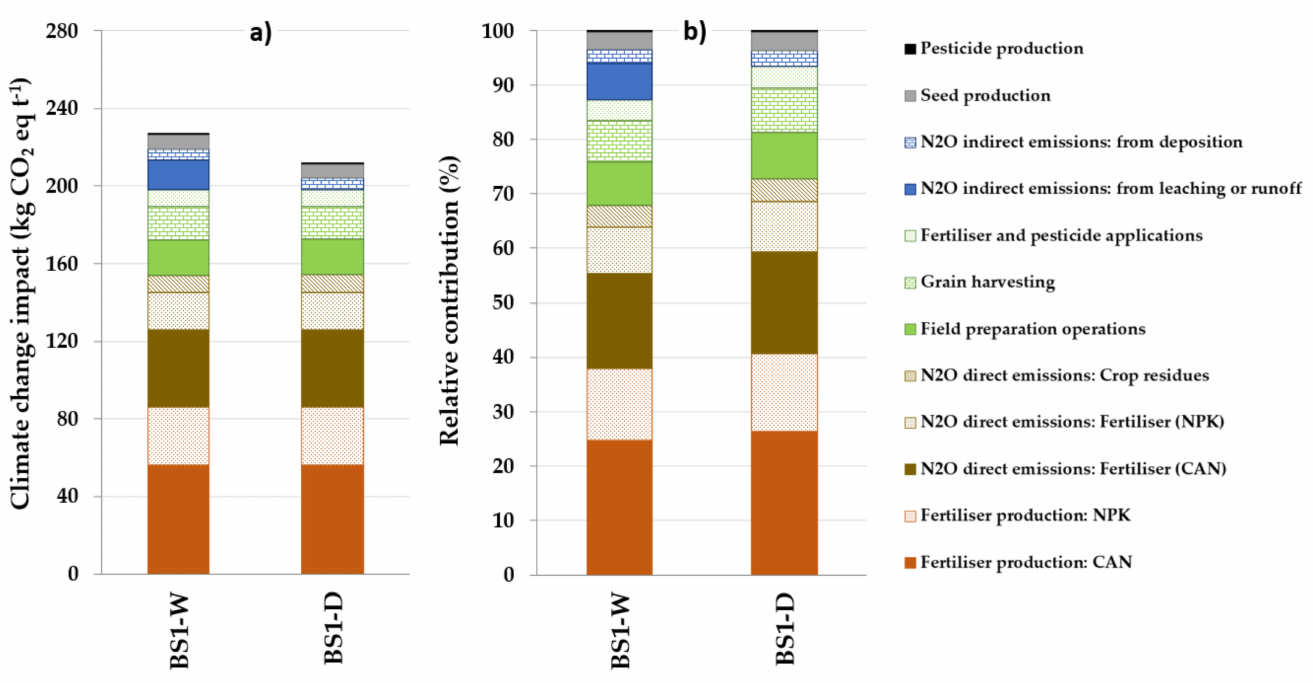
Figure 4. Climate change impact for the baseline scenario (BS1) under wet (W) and dry (D) climates: ( a ) kg CO 2 eq t − 1 and ( b ) percentages of the relative contributions of the main emissions